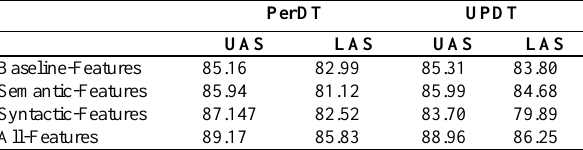
Table 6. Non-Projective-Second-Order.